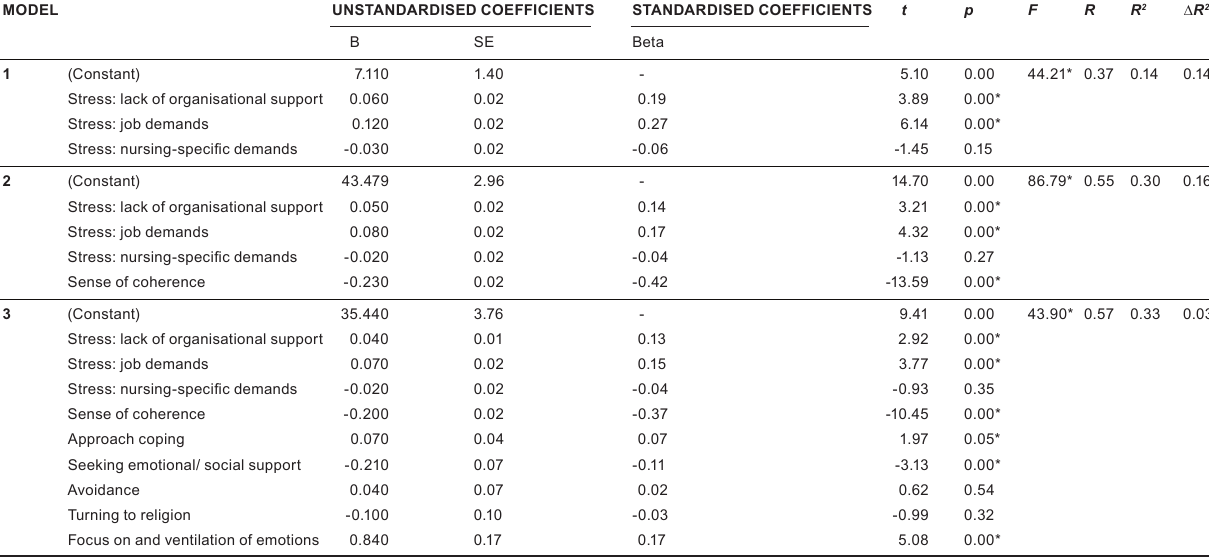
TABLE 3 Multiple regression analysis with Emotional Exhaustion as dependent variable and Occupational Stressors, Coping Strategies and Sense of Coherence as independent variables moDEL unSTAnDArDISED CoEFFICIEnTS STAnDArDISED CoEFFICIEnTS